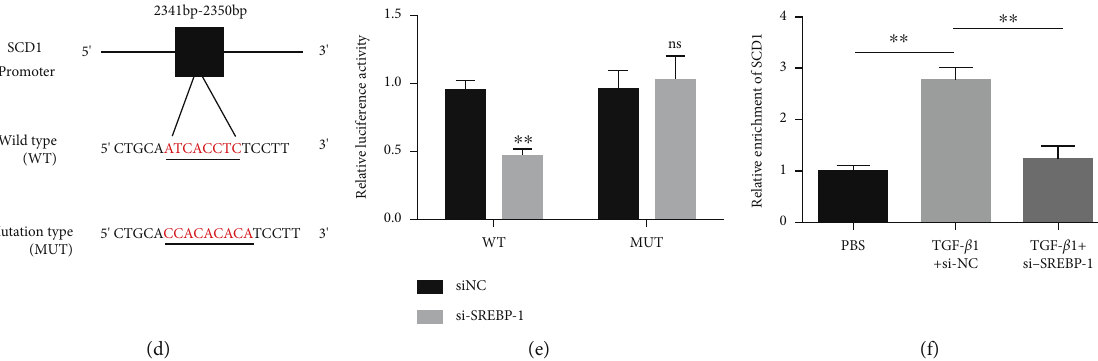
Figure 7: SREBP-1 is required for SCD1 transcriptional response. (a) The SREBP-1 levels in MSCs TGF- β 1 , MSC TGF- β 1 -EVs, MSC TGF- β 1 -EV- si-NC, or MSC TGF- β 1 -EV-si-SREBP-1 were assessed by western blotting, n = 3 . (b) MSCs were treated with TGF- β 1, and nuclear SREBP-1 translocation was assessed by immuno fl uorescence, with quanti fi cation shown in the bar graph, n = 3 . (c) The SCD1 protein levels in MSCs TGF- β 1 and MSC TGF- β 1 -EVs treated with si-NC or si-SREBP-1 were assessed by western blotting, n = 3 . (d) Schematics of the SCD1 promoter and luciferase construct are depicted with the binding site and deletion mutation sequences. (e) Relative luciferase activity of the WT SCD1 promoter or the MUT promoter was detected, n = 3 . (F) ChIP assay shows binding of SREBP-1 to the SCD1 promoter is enhanced by TGF- β 1 stimulation, n = 3 . Data are expressed as mean ± SD ; ∗∗ P < 0 : 01 and ∗∗∗ P < 0 : 001 . ns: no signi fi cance; MSCs: mesenchymal stem cells; EVs: extracellular